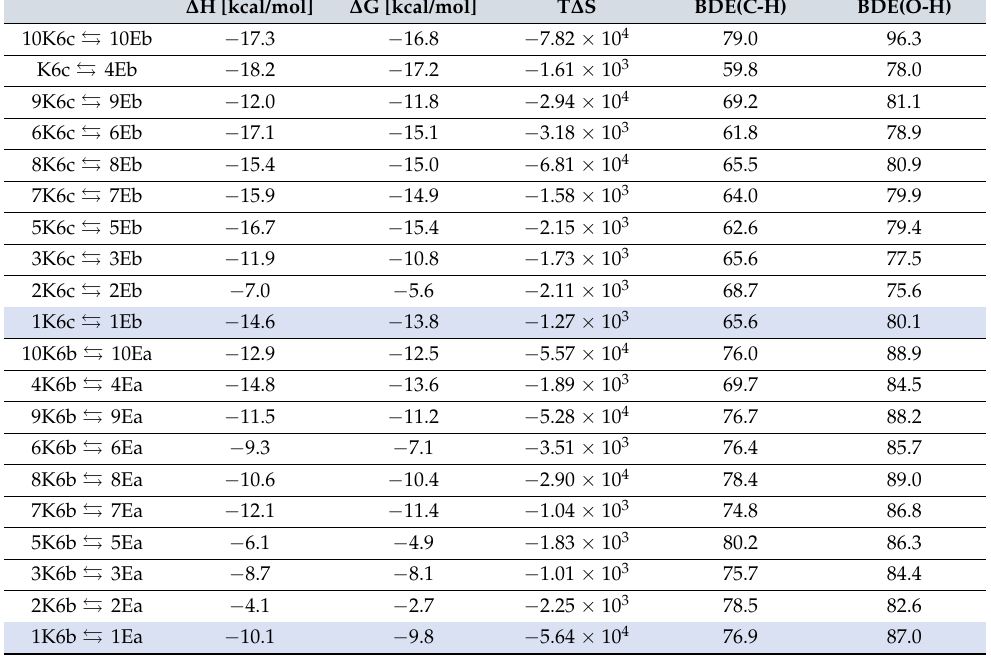
Table 5. Enthalpy ( ∆ H) and Free Energy ( ∆ G) at 298 K for Tautomerization and the Bond Dissociation Enthalpy, BDE, in the enones (C-H) and in the enols (O-H). Structures without substituents are marked